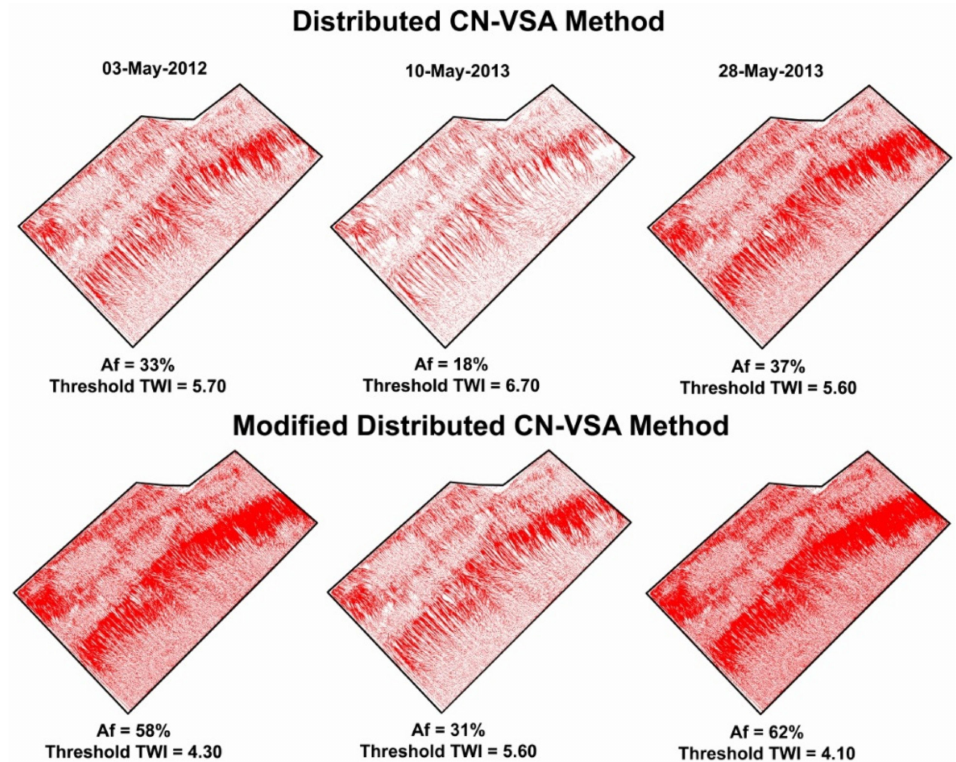
Figure 11. Comparison of spatial distribution of surface runoff estimated by distributed CN–VSA method and modified distributed CN–VSA method for spring rainfall events.